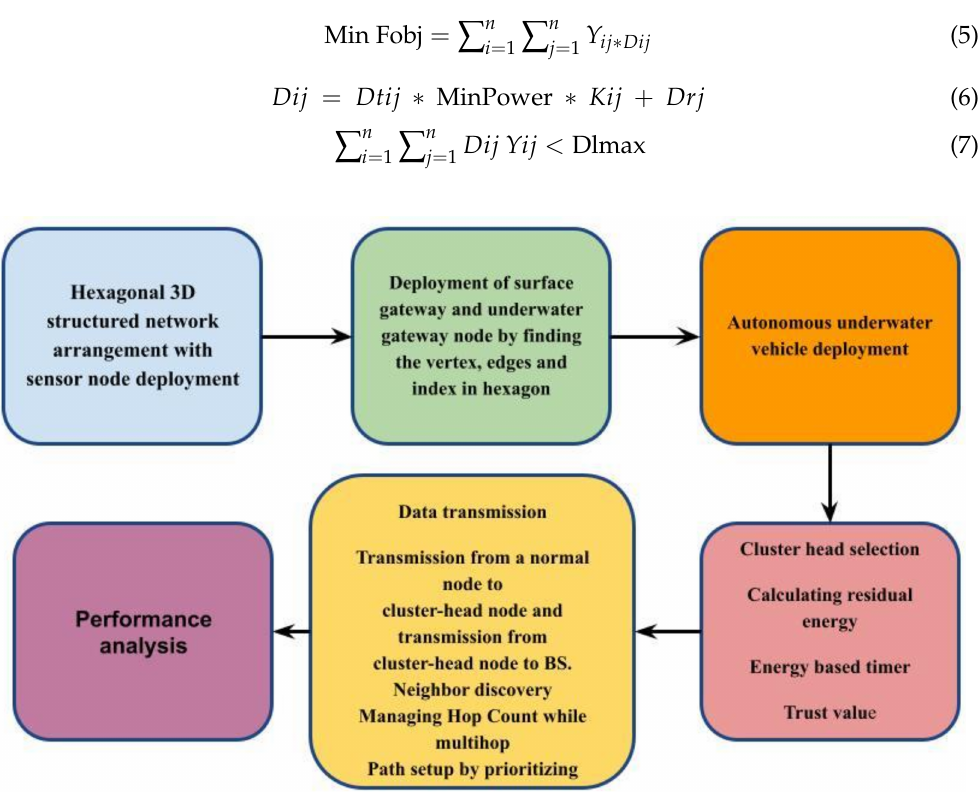
Figure 3. Proposed system